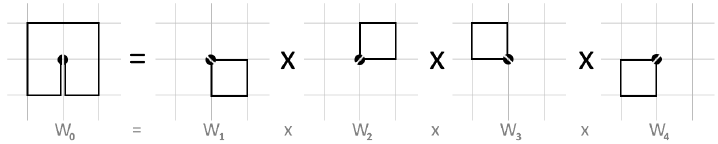
Figure 5. To measure the color homogeneity of a 2 2-loop its four plaquettes are referenced to the central lattice point of the 2 2-loop.